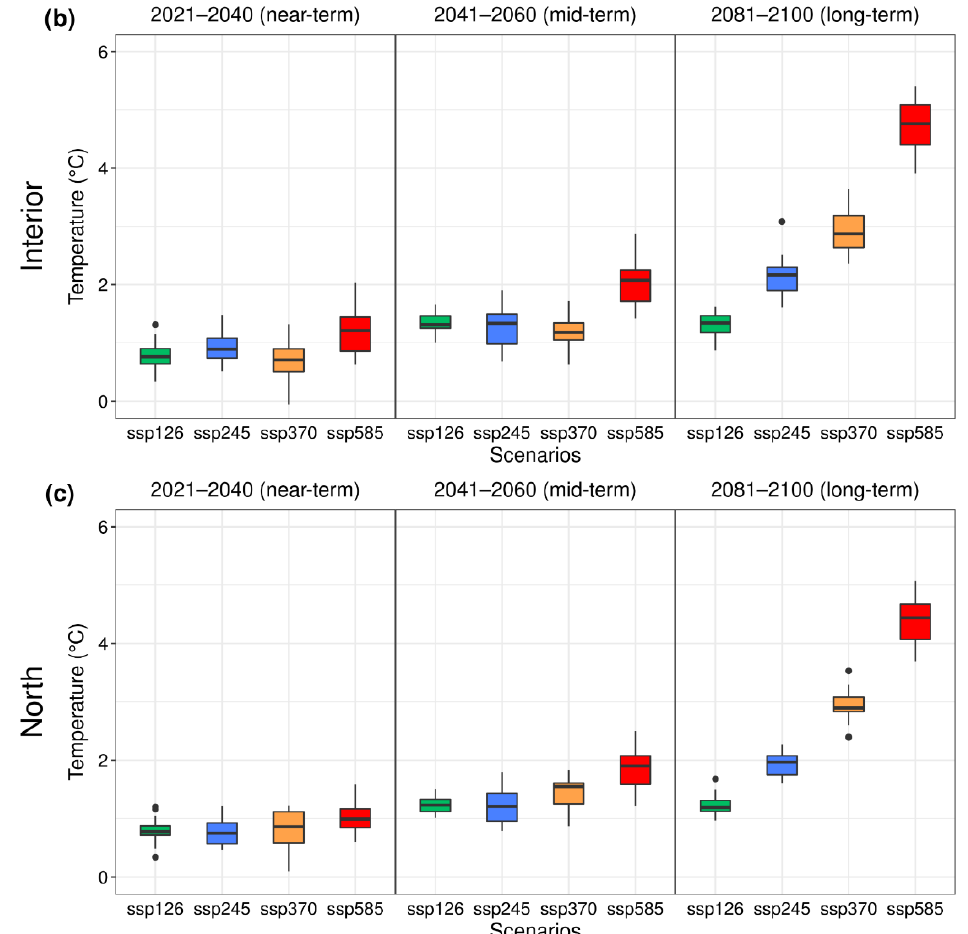
Figure 13. Boxplot of the air temperature anomaly CMIP6 for the near-term, mid-term, and long- term (end of the century) periods: ( a ) East Coast, ( b ) Interior, and ( c ) North. The colored box plot corresponds to the average of the 5 best models (ensemble) of CMIP6 for the SSP1-2.6, SSP2-4.5, SSP3-7.0, and SSP5-8.5 scenarios.